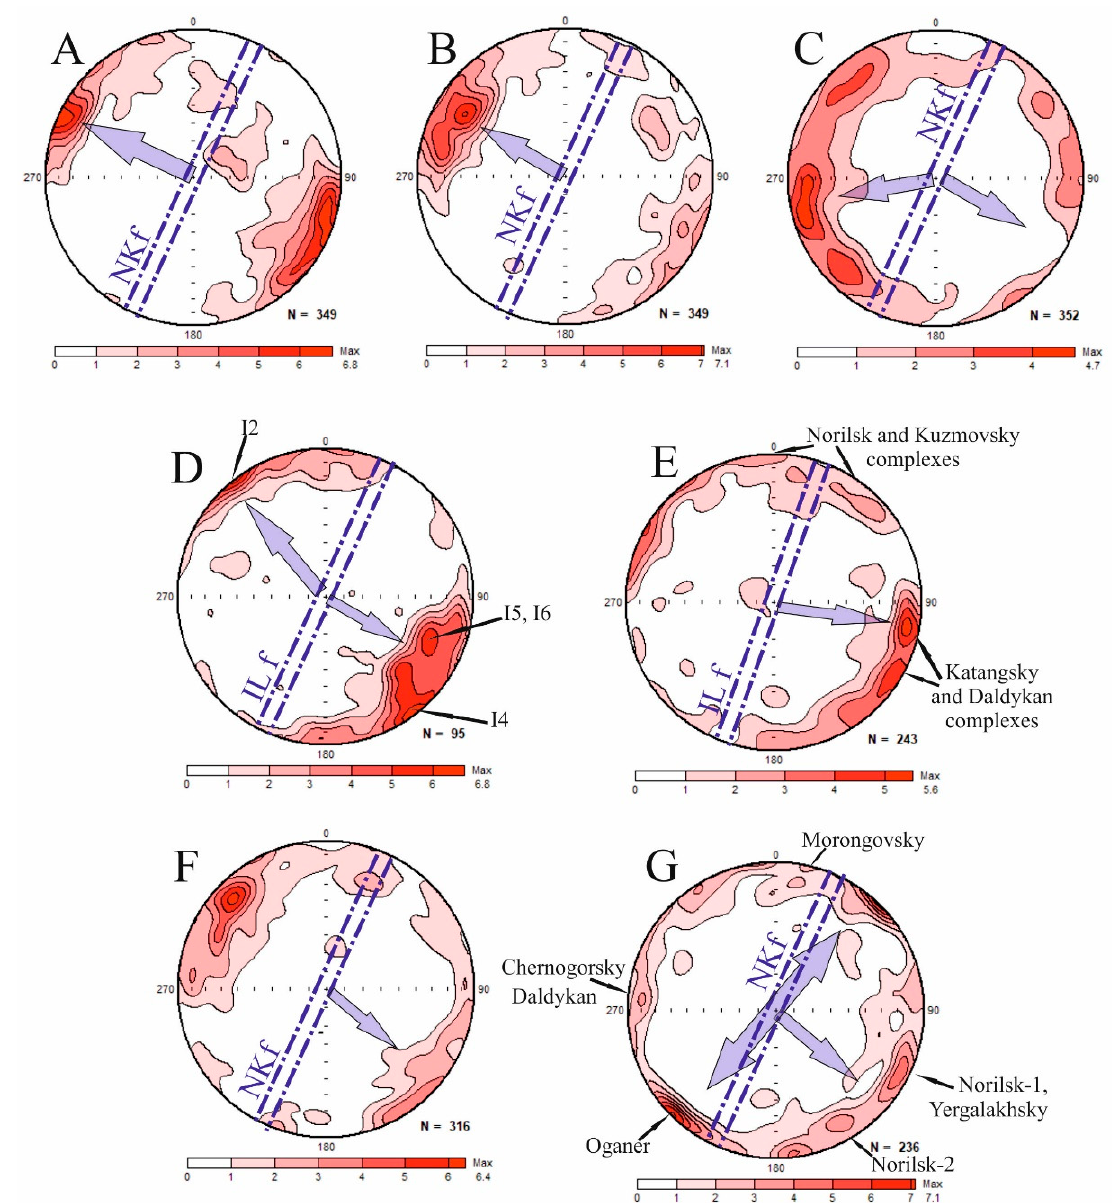
Figure 8. Contour plots of the maximal axis K1 of AMS for the studied regions. Lower hemisphere, equal area projection. ( A , B ) Mokulay: ( A ) “in situ”, ( B ) tilt-corrected; ( C ) Talovaya; ( D ) Imangda; ( E ) Kulumbe; ( F ) Kharaelakh; ( G ) Noril’sk. Arrows show directions of the magma transport.